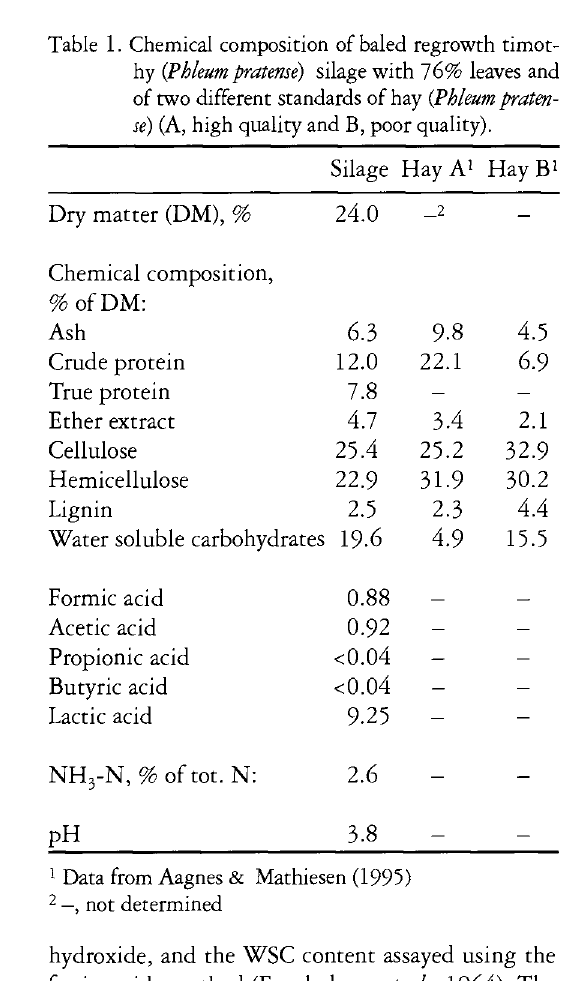
Table 1. Chemical composition of baled regrowth timot hy (Phleum pratense) silage with 76% leaves and of two different standards of hay (Phleum praten se) (A, high quality and B, poor